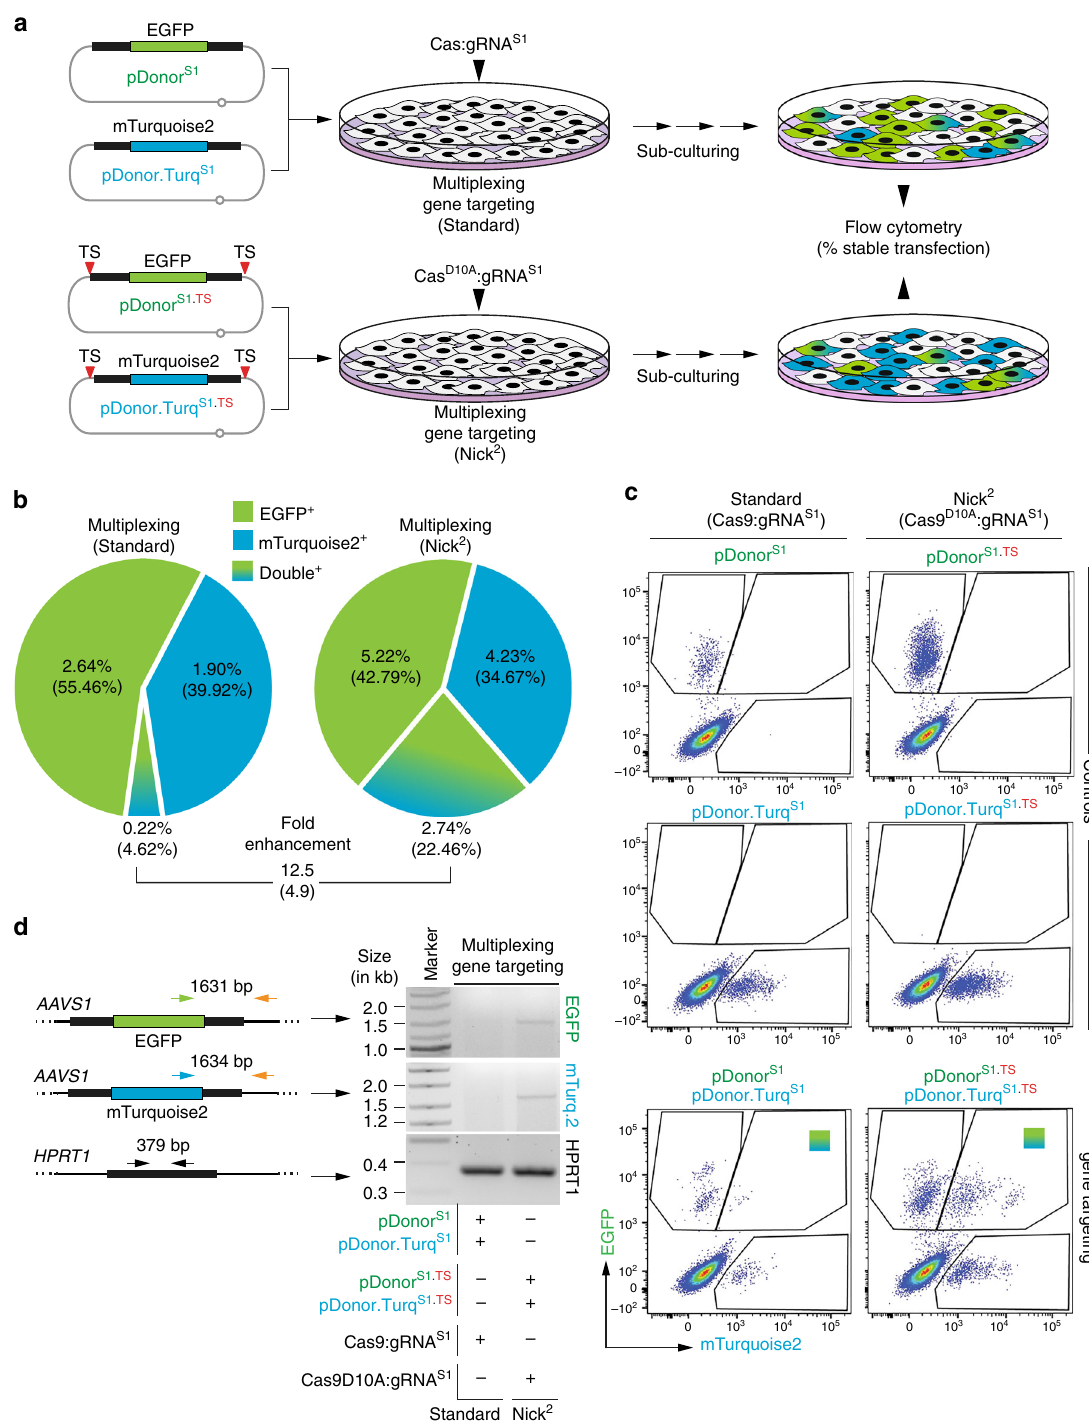
Fig. 5 Multiplexing homology-directed DNA addition. a Diagram of the experimental design. HeLa cells were co-transfected with the indicated donor constructs together with plasmids encoding either cleaving Cas9:gRNA S1 or nicking Cas9 D10A :gRNA S1 complexes. b Quanti fi cation of stably transfected cell populations. The frequencies of genetically modi fi ed cells were determined at 27 days post-transfection by EGFP-directed and mTurquoise2-directed fl ow cytometry. The ratios between the frequencies of the double-positive cell populations generated by standard and in trans paired nicking multiplexing, are presented. Numerals between brackets correspond to the fraction of each gene-modi fi ed subpopulation. c Flow cytometry dot plots corresponding to the end-point of the experiments. Parallel cultures transfected with a single donor construct mixed with plasmids expressing Cas9:gRNA S1 or Cas9 D10A :gRNA S1 served as controls for setting the thresholds for EGFP and mTurquoise2 detection. d Gene co-targeting in cells containing a mixture of two donors resistant or susceptible to RGN nicking. PCR products speci fi c for homology-directed gene targeting involving EGFP-encoding and mTurquoise2-encoding donor templates are indicated. HPRT1 provided for an internal control target